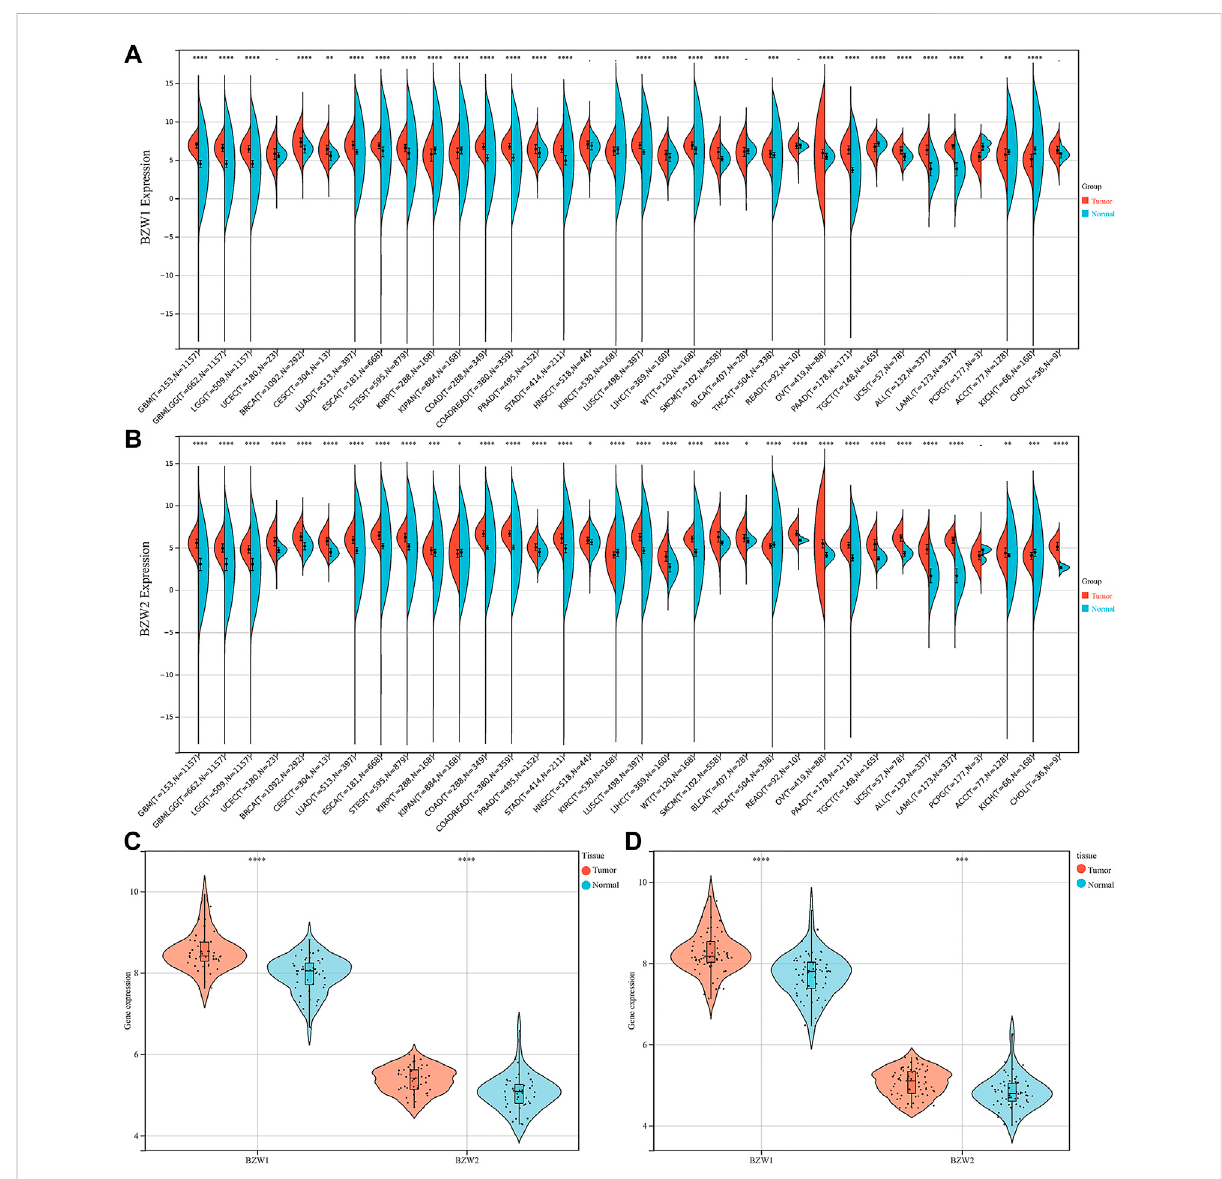
FIGURE 1 BZW1 (A) and BZW2 (B) expression in pan-cancer. Expression of BZW1 and BZW2 was upregulated in tumor tissues in GSE28735 (C) and GSE62452 (D) cohorts. * p < 0.05, ** p < 0.01, *** p < 0.001, **** p <